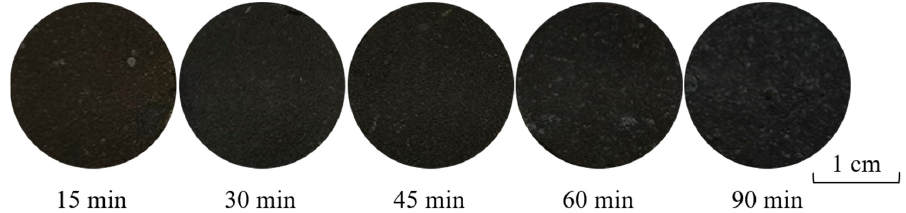
Figure 10. Ceramic tile samples with Fe / Cr = 2.0 sintered at 1150 ◦ C for di ff erent time.